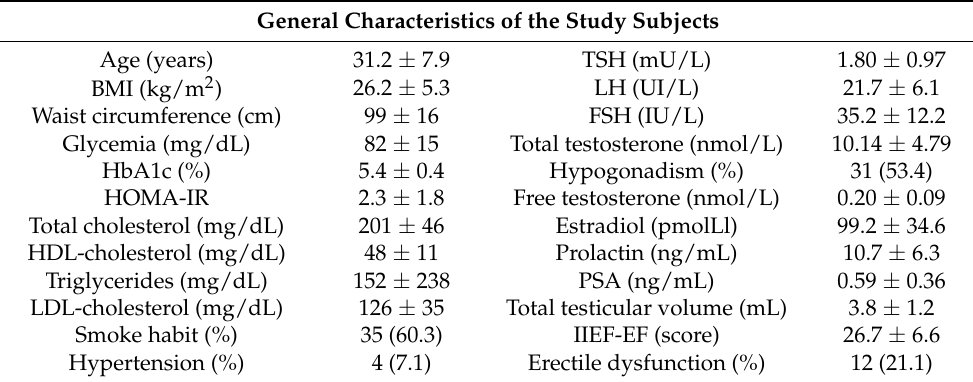
Table 1. General characteristics of the study subjects. General Characteristics of the Study